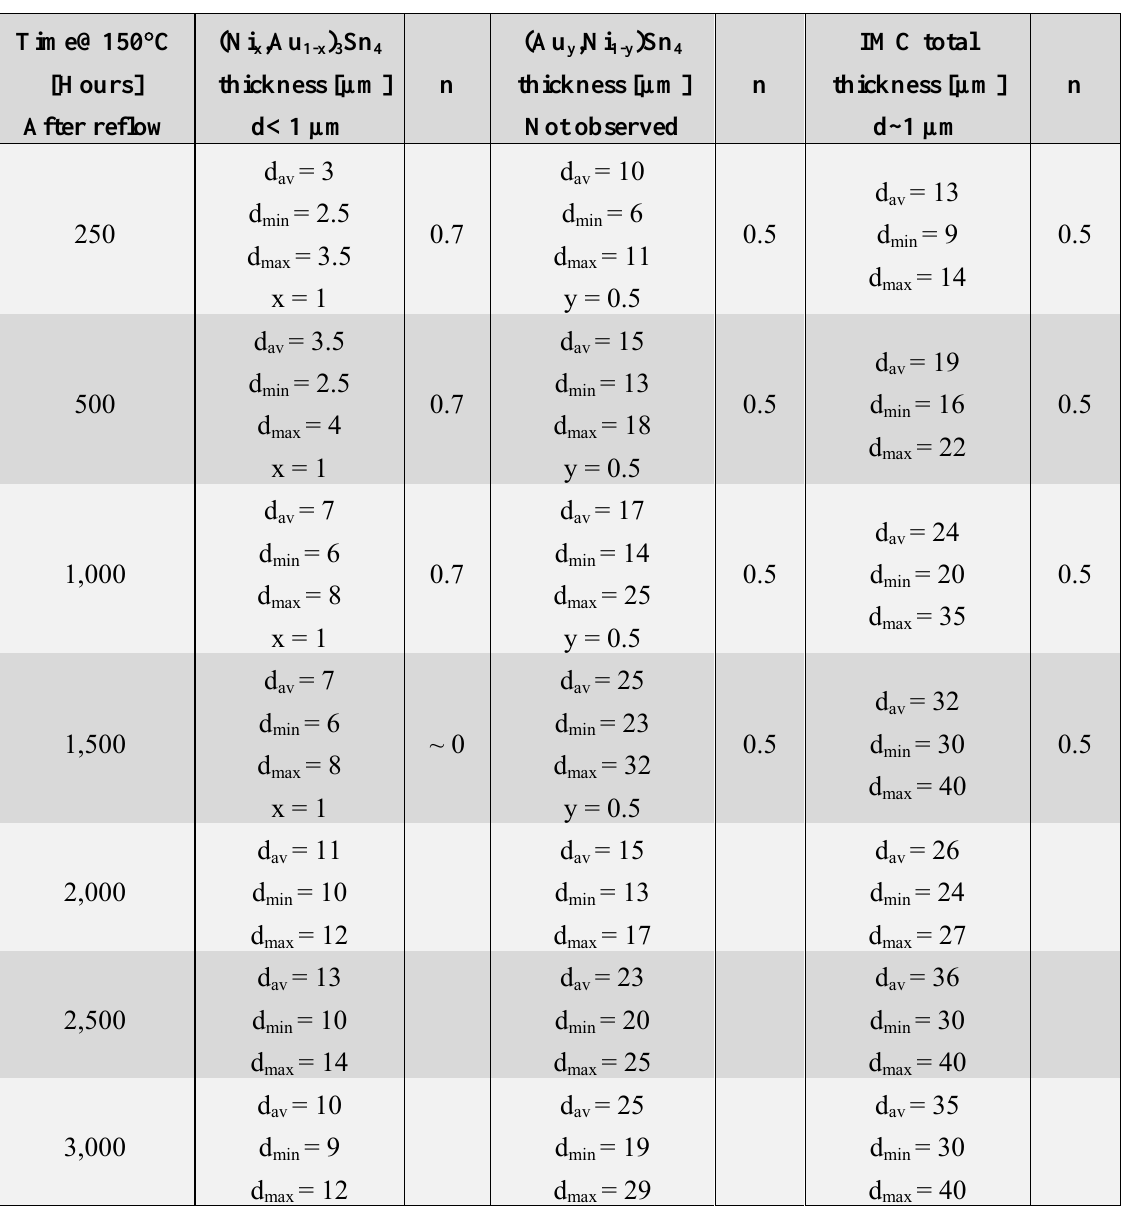
Table 1. Minimum (d compositions as well as the growth exponents (n) determined by the regression analysis for the phases formed in (SnPbAg)/Ni/Au reaction